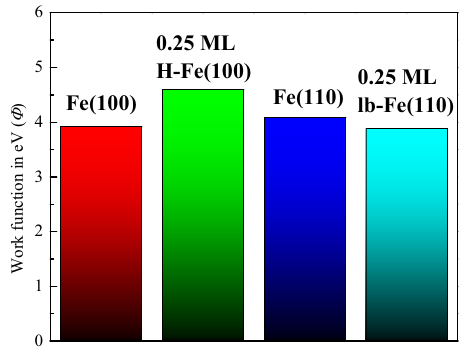
Figure 6: Values of the work function for the Fe ( 100 ) /Fe ( 110 ) surface and selected Cl –